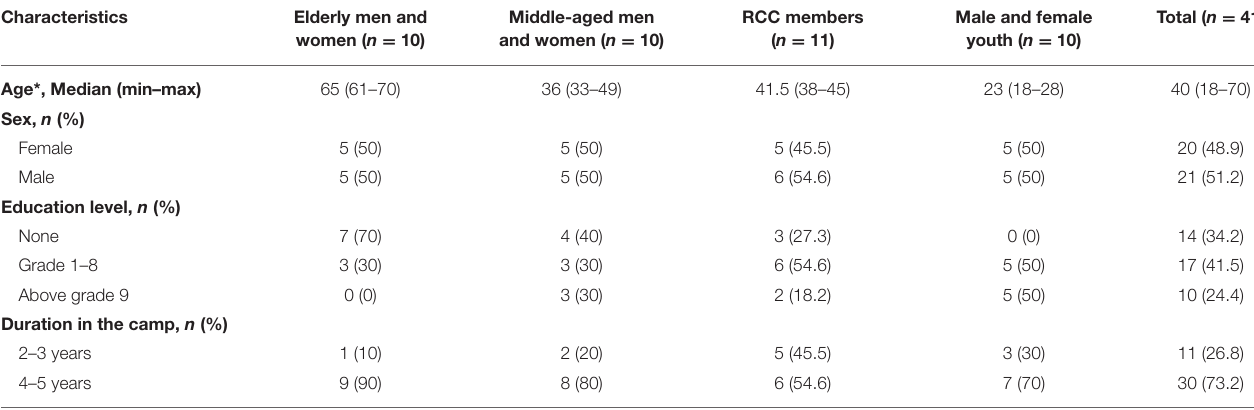
TABLE 1 | Characteristics of participants of focus group discussions.